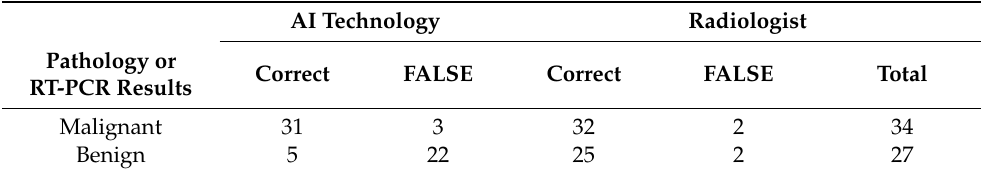
Table 1. The prediction results of the 61